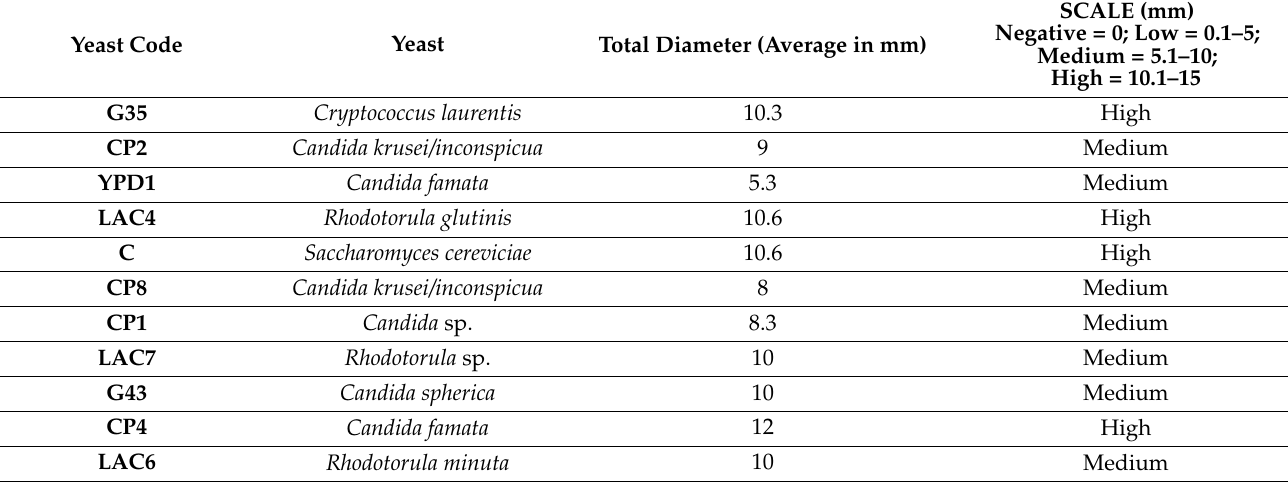
Table 2. Lipase test on agar surface with neutral